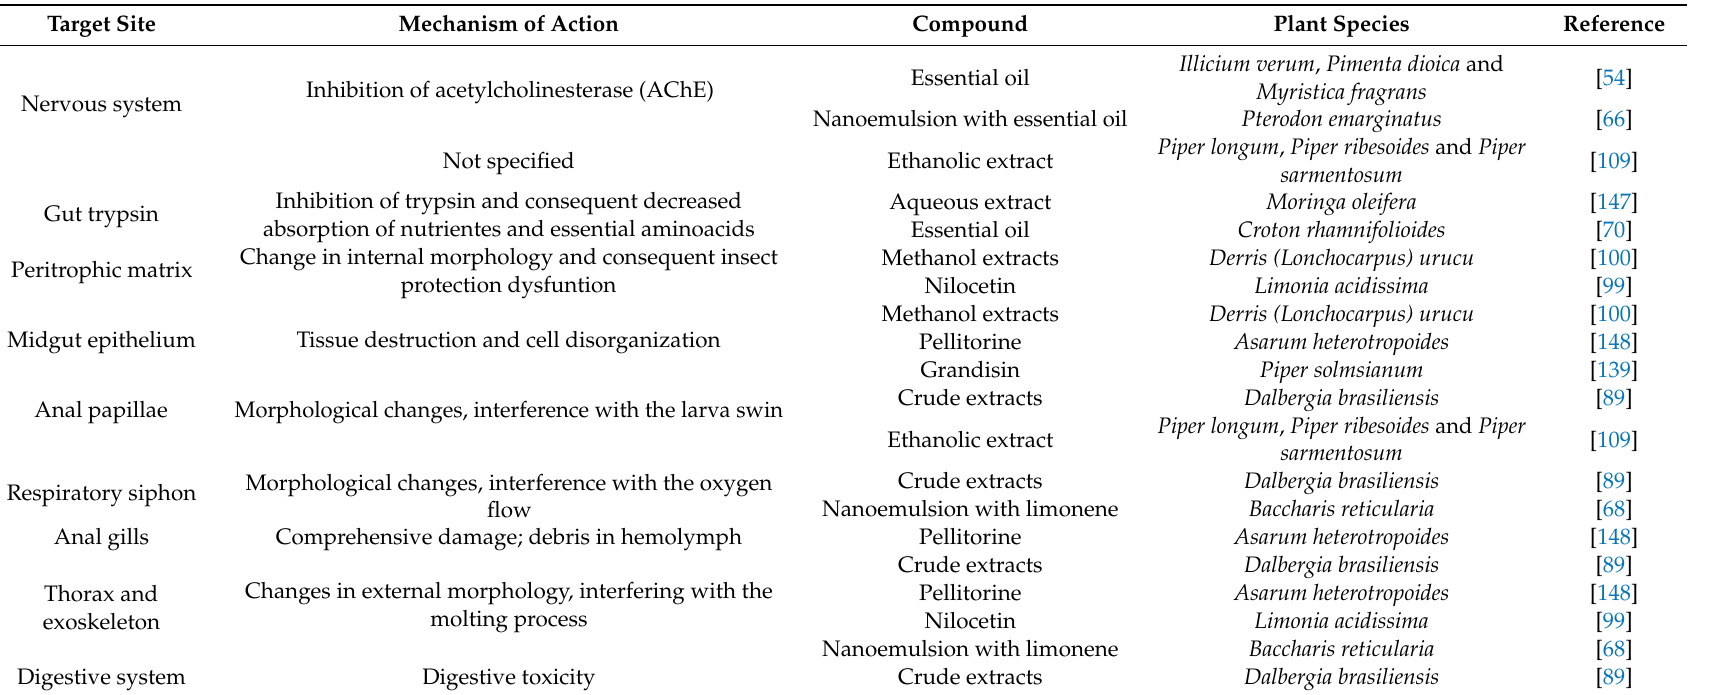
Table 5. Mechanisms of action of botanicals against the Ae. aegypti